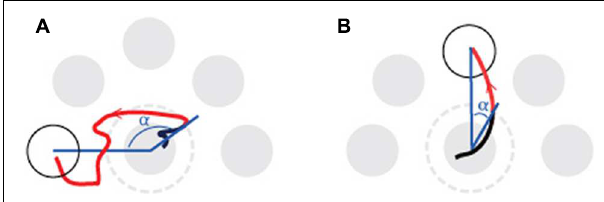
FIGURE 2 | Illustration of the center-out movement to a presented radial target (white) and the outcome parameters directional error and homing time. The figure is based on one trial of a young subject at the start (A) and at the end (B) of a practice session. The angle ( α ) between the two blue lines determines the directional error. The homing time is the time it takes from leaving the dotted circle to stabilizing on the radial target (red trajectory). At the start of the experiment the subject had a larger homing time and a larger directional error than at the end of the practice session (left panel vs. right